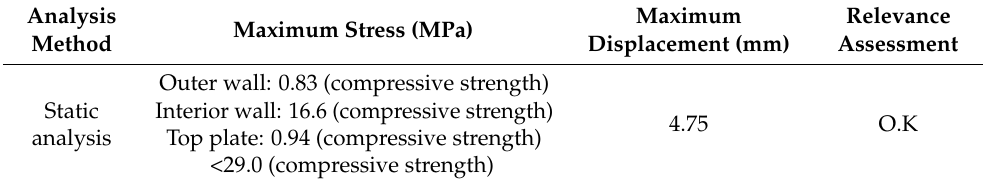
Figure 12. Computational finite element analysis results (displacement). Table 9. Summary of static analysis results.